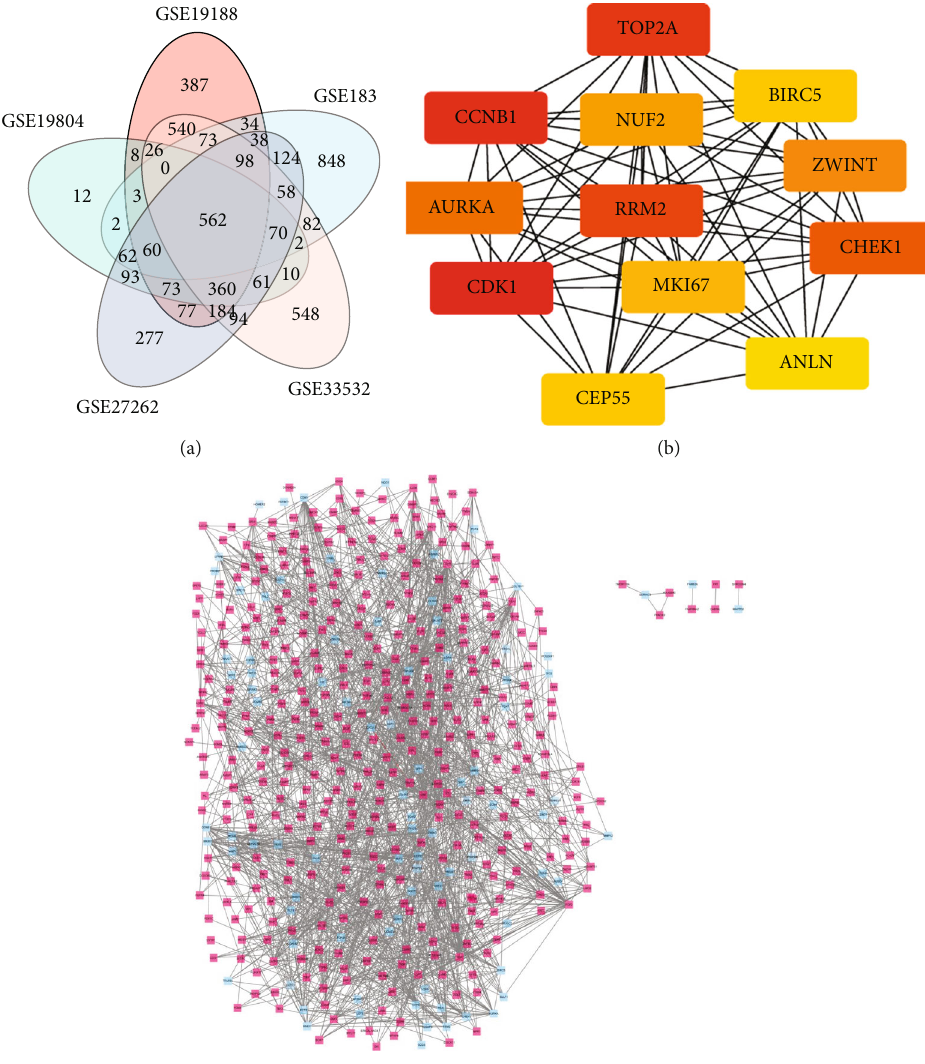
Figure 1: Venn diagram, PPI network, and the most signi fi cant module of DEGs. (a) DEGs were selected with a fold change > 1 and P value < 0.01 among the mRNA expression pro fi ling set GSE19804, GSE118370, GSE19188, GSE27262, and GSE33532. The 5 datasets showed an overlap of 562 genes. (b) The most signi fi cant module was obtained from PPI network with 12 nodes and 66 edges. (c) The PPI network of DEGs was constructed using Cytoscape. Upregulated genes are marked in light red; downregulated genes are marked in light